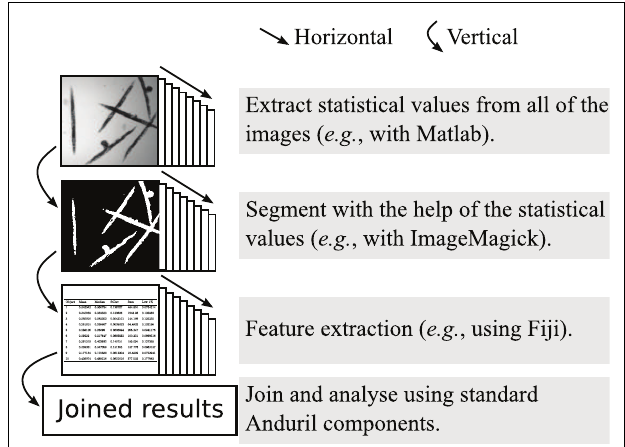
FIGURE 2 |An example of the horizontal data flow, where images are segmented and extracted for numerical features .The horizontal data flow allows the inspection of the suitability of the thresholding step for all of the images, before continuing with the time consuming feature